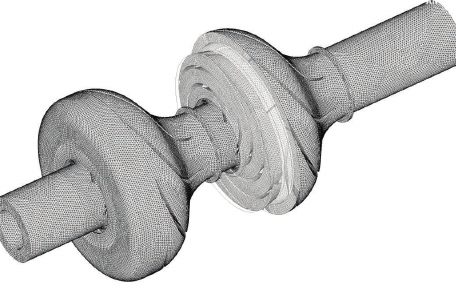
Figure 3: Grid view of computational